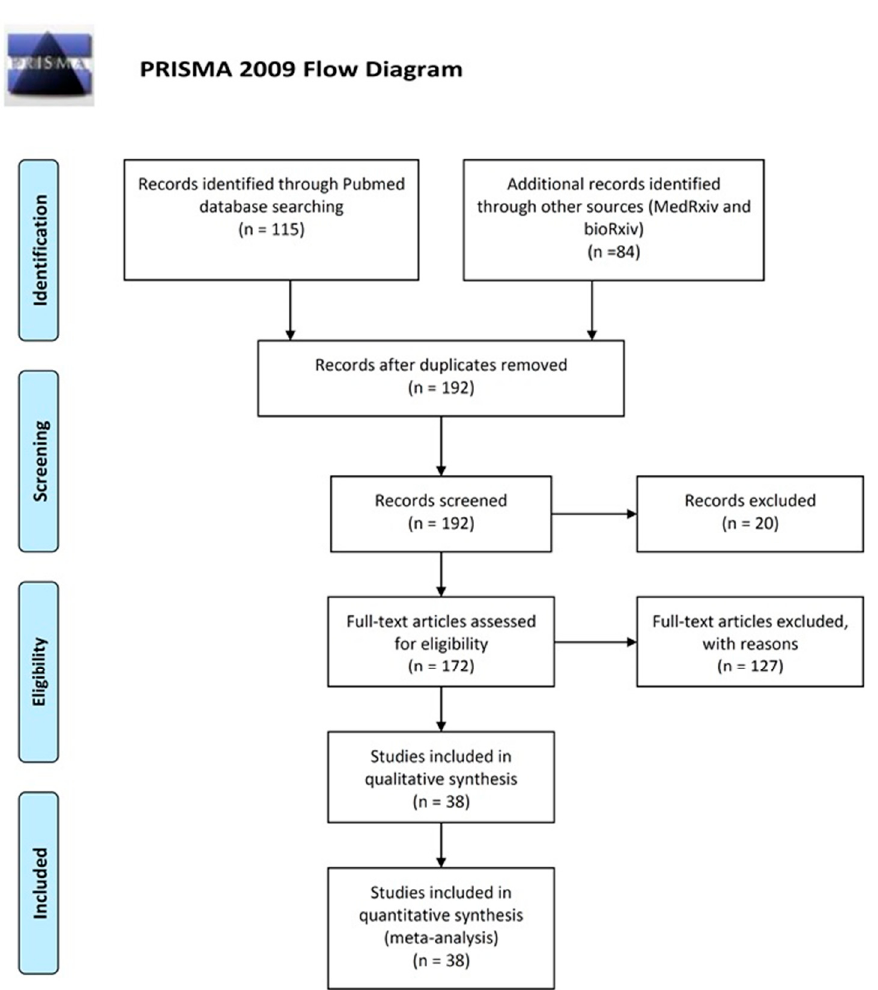
Figure 1. Preferred reporting items for systematic reviews and meta-analyses (PRISMA) flow diagram.